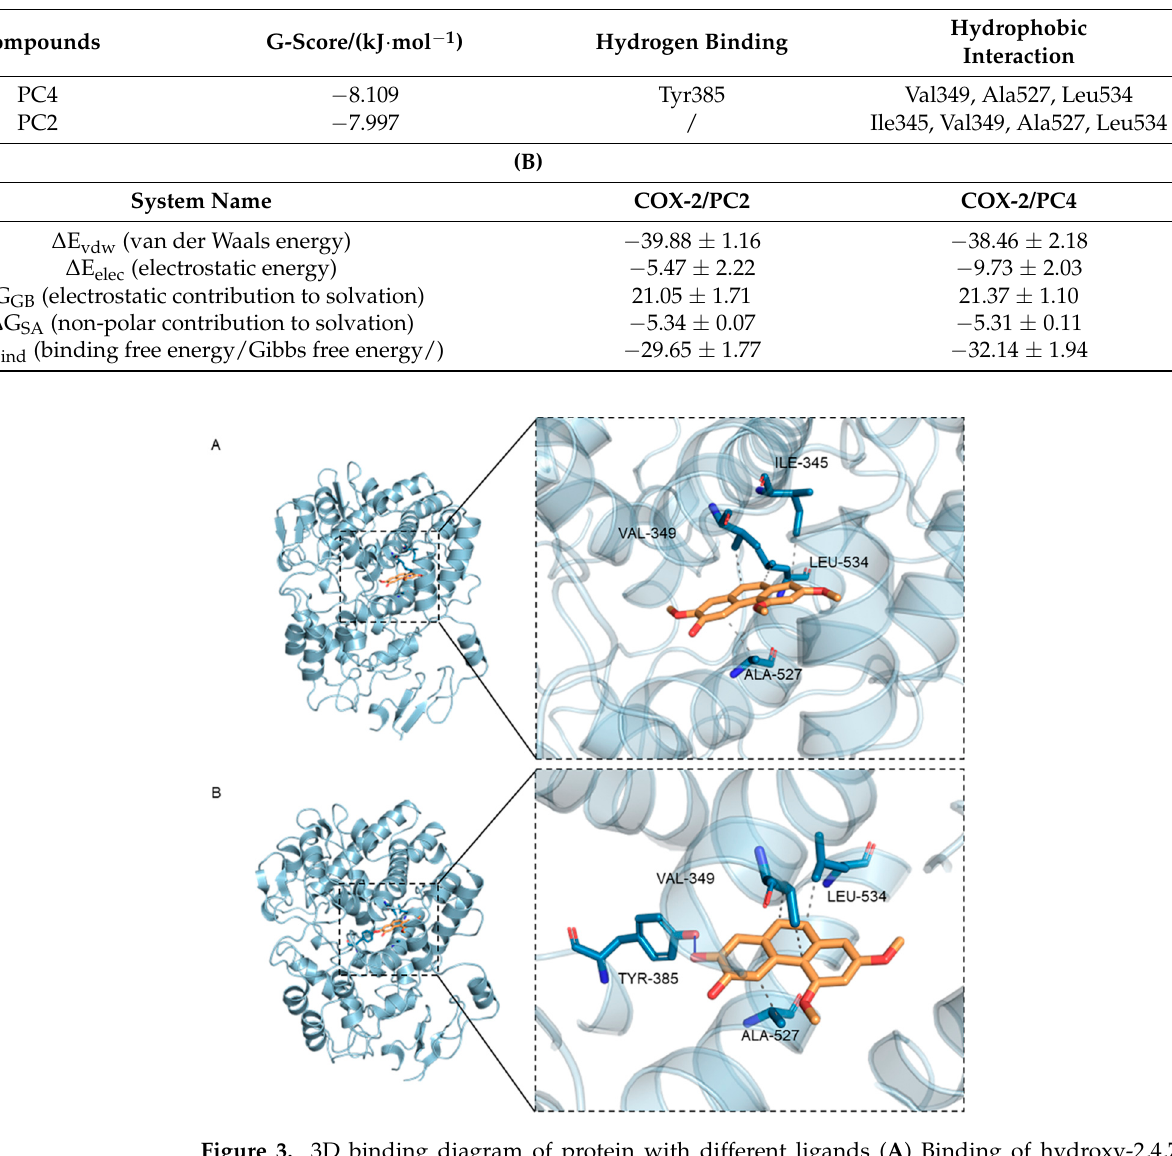
Figure 3. 3D binding diagram of protein with different ligands ( A ) Binding of hydroxy-2,4,7-trimethoxyphenanthrene (PC2) to cyclooxygenase-2 (COX-2) protein, ( B ) Binding of 6,7-dihydroxy- 2,4- dimethoxy-phenanthrene (PC4) to COX-2 protein. The left figure is the overall view and the right figure is the partial view. In the figure, yellow stick is small molecule and light blue cartoon is protein. The blue line indicates hydrogen bonding and the gray dotted line indicates